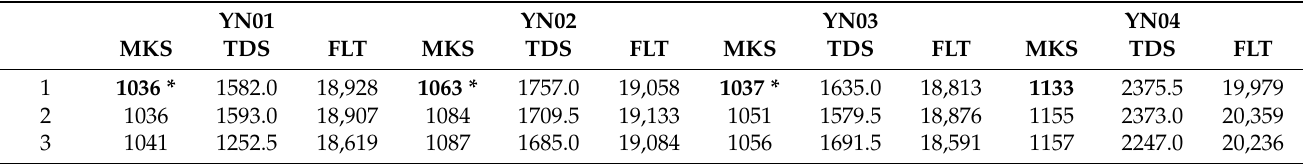
Table A19. Non-dominated solutions obtained by SS/CMOTA for the JSSP instances proposed by